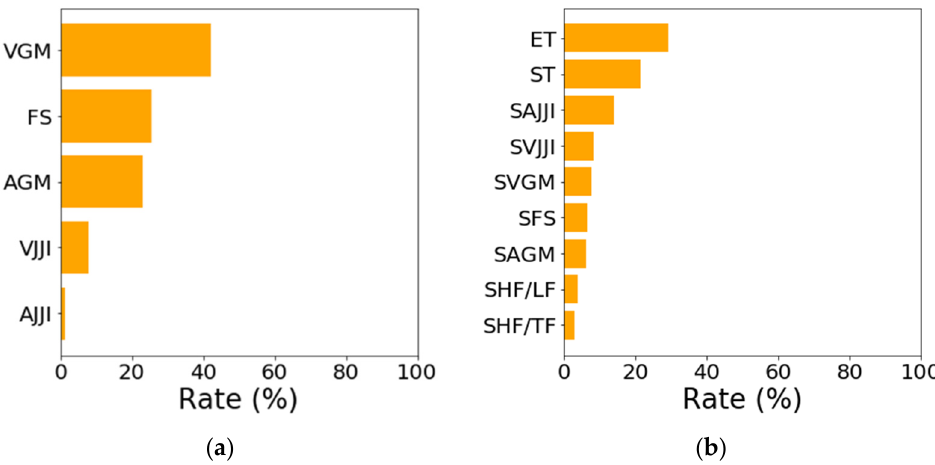
Figure 11. The estimated results of accuracy, F-score, precision, and recall ( n = 15).